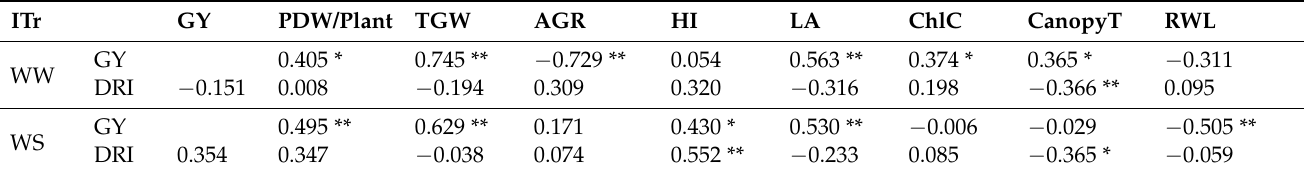
Table 2. Correlation analysis of agronomic and physiological traits with the grain yield and drought resistance for foxtail millet varieties grown under two irrigation treatments for five